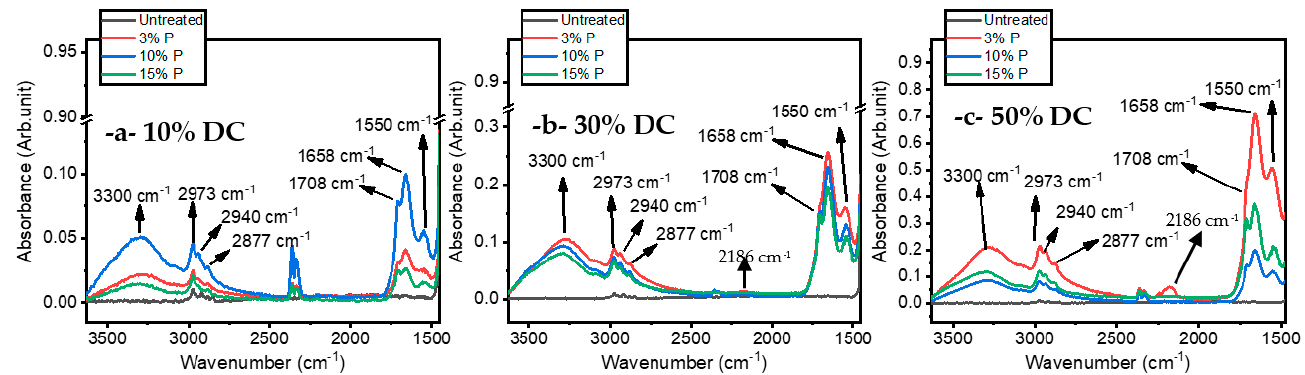
Figure 9. Normalized FTIR absorption spectrum of the ETFE as a function of the precursor concentration (i.e,. 3%, 10%, 15%) for ( a ) 10% DC, ( b ) 30% DC, ( c ) 50% DC.